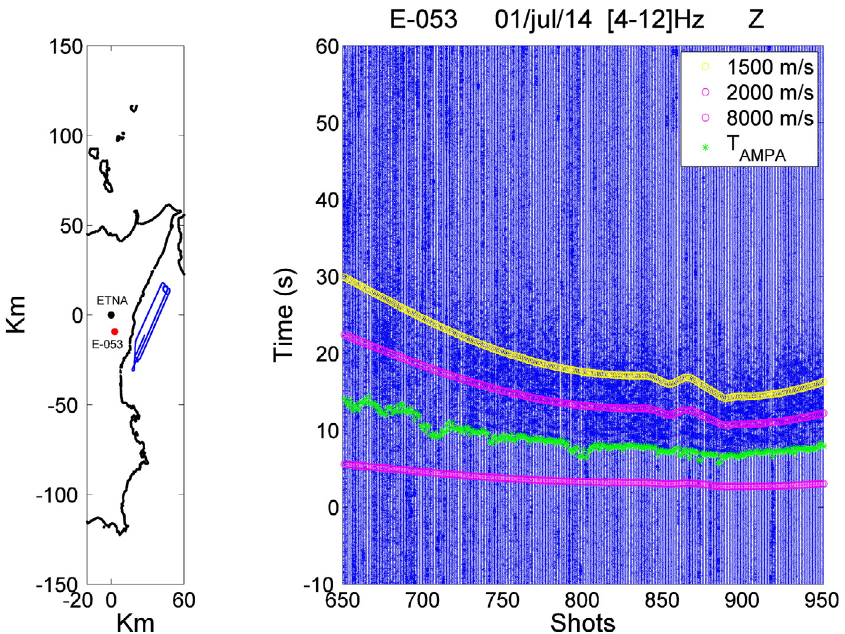
amplitude decreases two points comparing max